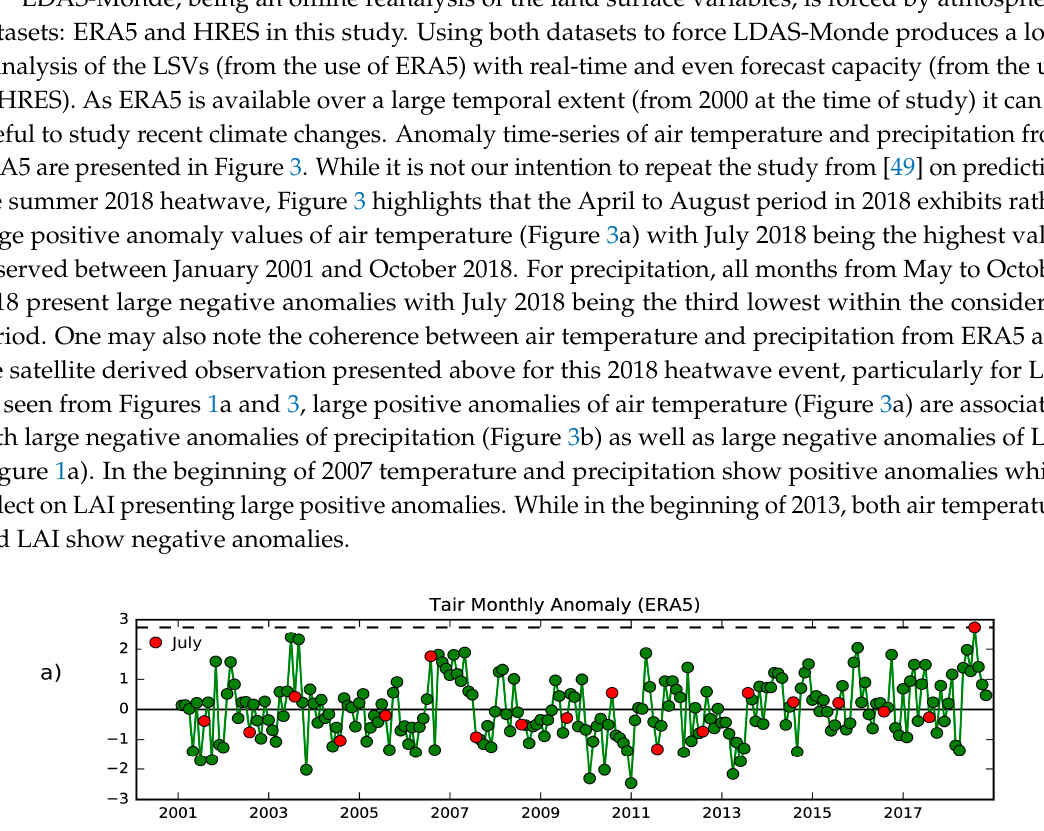
Figure 4. ( a ) Observed CGLS GEOV2 Leaf Area Index (LAI) (green stars) over January 2008 to December 2018 as well as LDAS-Monde LAI time-series forced by either ERA5 (Open-loop is in blue, analysis is in red) over January 2008–October 2018 or high resolution operational analysis (HRES) (Open-loop is in cyan, analysis is in orange) over April 2016–December 2018. ( b ) Same as a) over Land Data Assimilation System (LDAS)-HRES and LDAS-ERA5 common period (April 2016 to October 2018). Data are averaged over the domain illustrated by Figure 2, dashed line represents the date from when HRES is available (April 2016) and the date up to when ERA5 is available (at the time of the study).